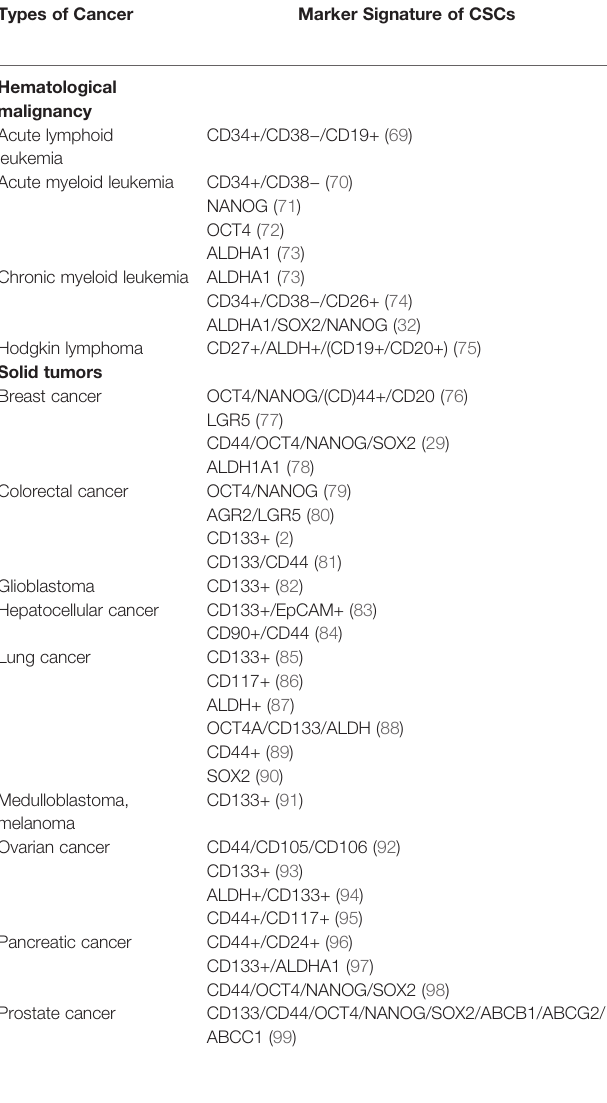
TABLE 2 | Markers of CSCs for different malignancies.